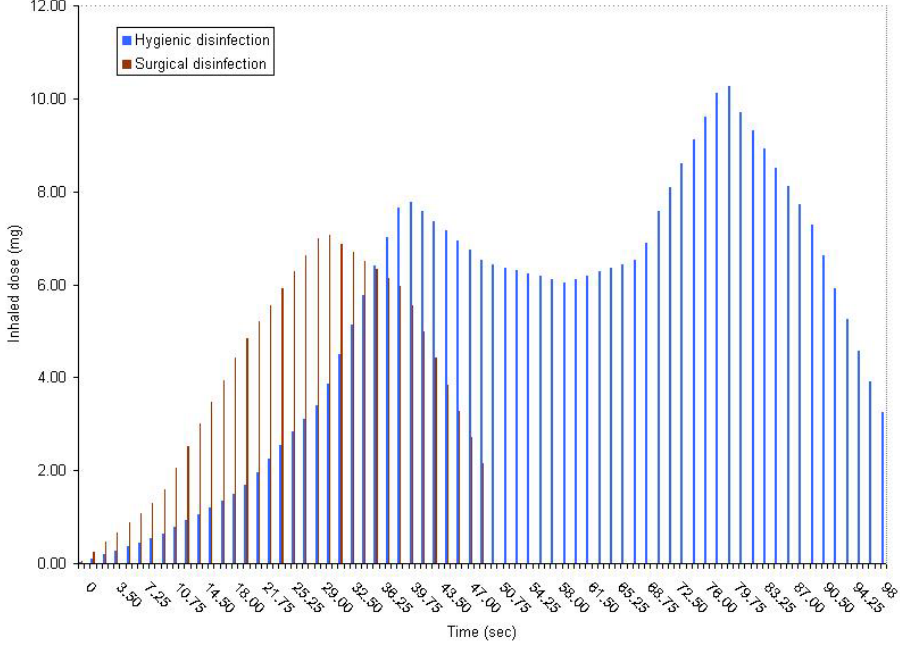
Figure 5. Evolution of inhaled doses (mean) during hygienic and and surgical hand disinfection with hand rub